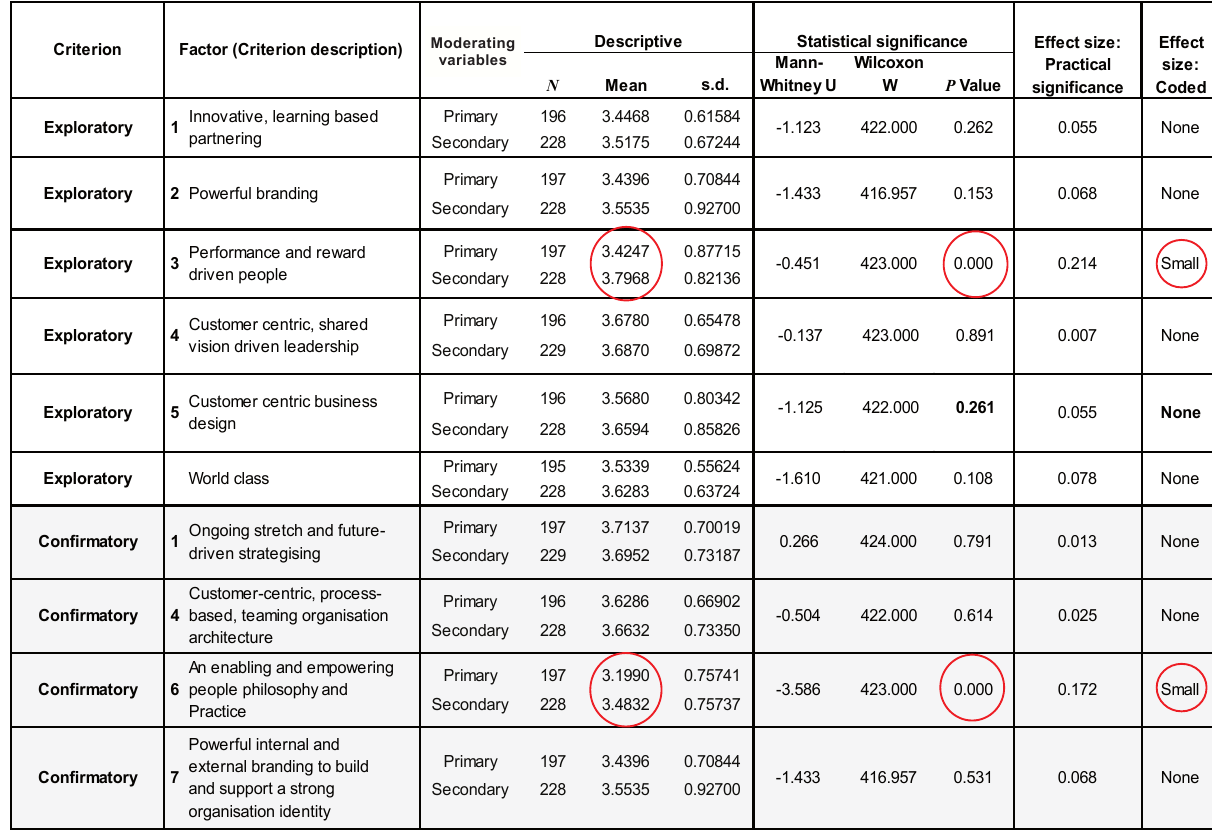
TABLE 3 Individual respondents as unit of analysis: primary versus secondary sectors irrespective of developed/developing country